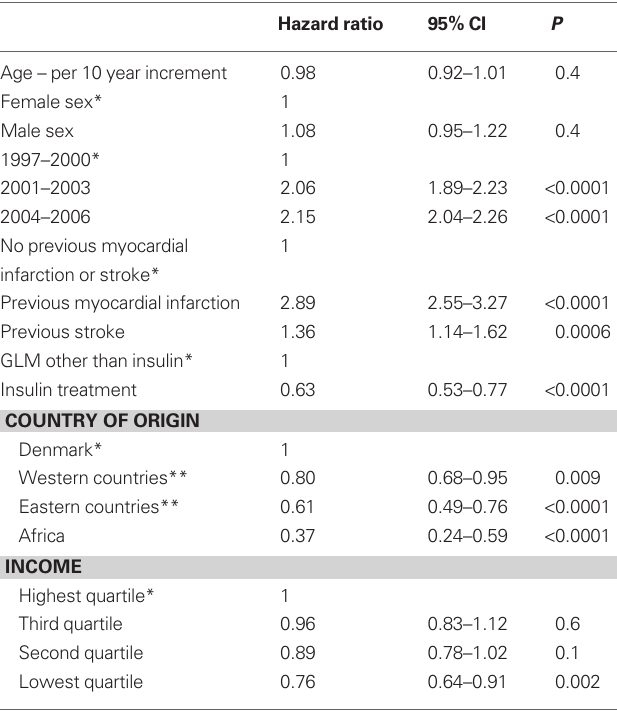
Table 2 | Cox proportional analysis on the proportion of subjects who initiated statin treatment after the first claimed prescription of glucose-lowering